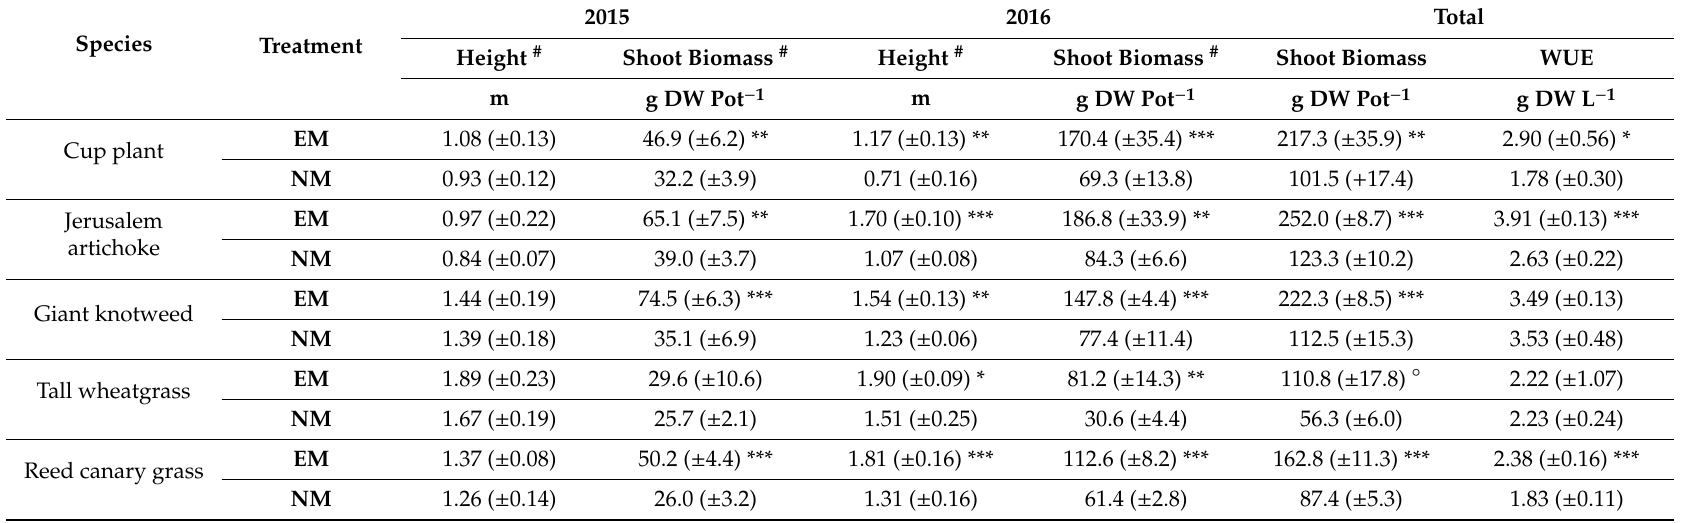
Table 4. Growth parameters (mean values ± standard deviation, n = 5) of tested plant species for both experimental years and as a summary value for the whole experiment. Significant di ff erences between both soil moisture treatments (‘EM’: excess soil moisture, ‘NM’: non-excess soil moisture) of a certain species are